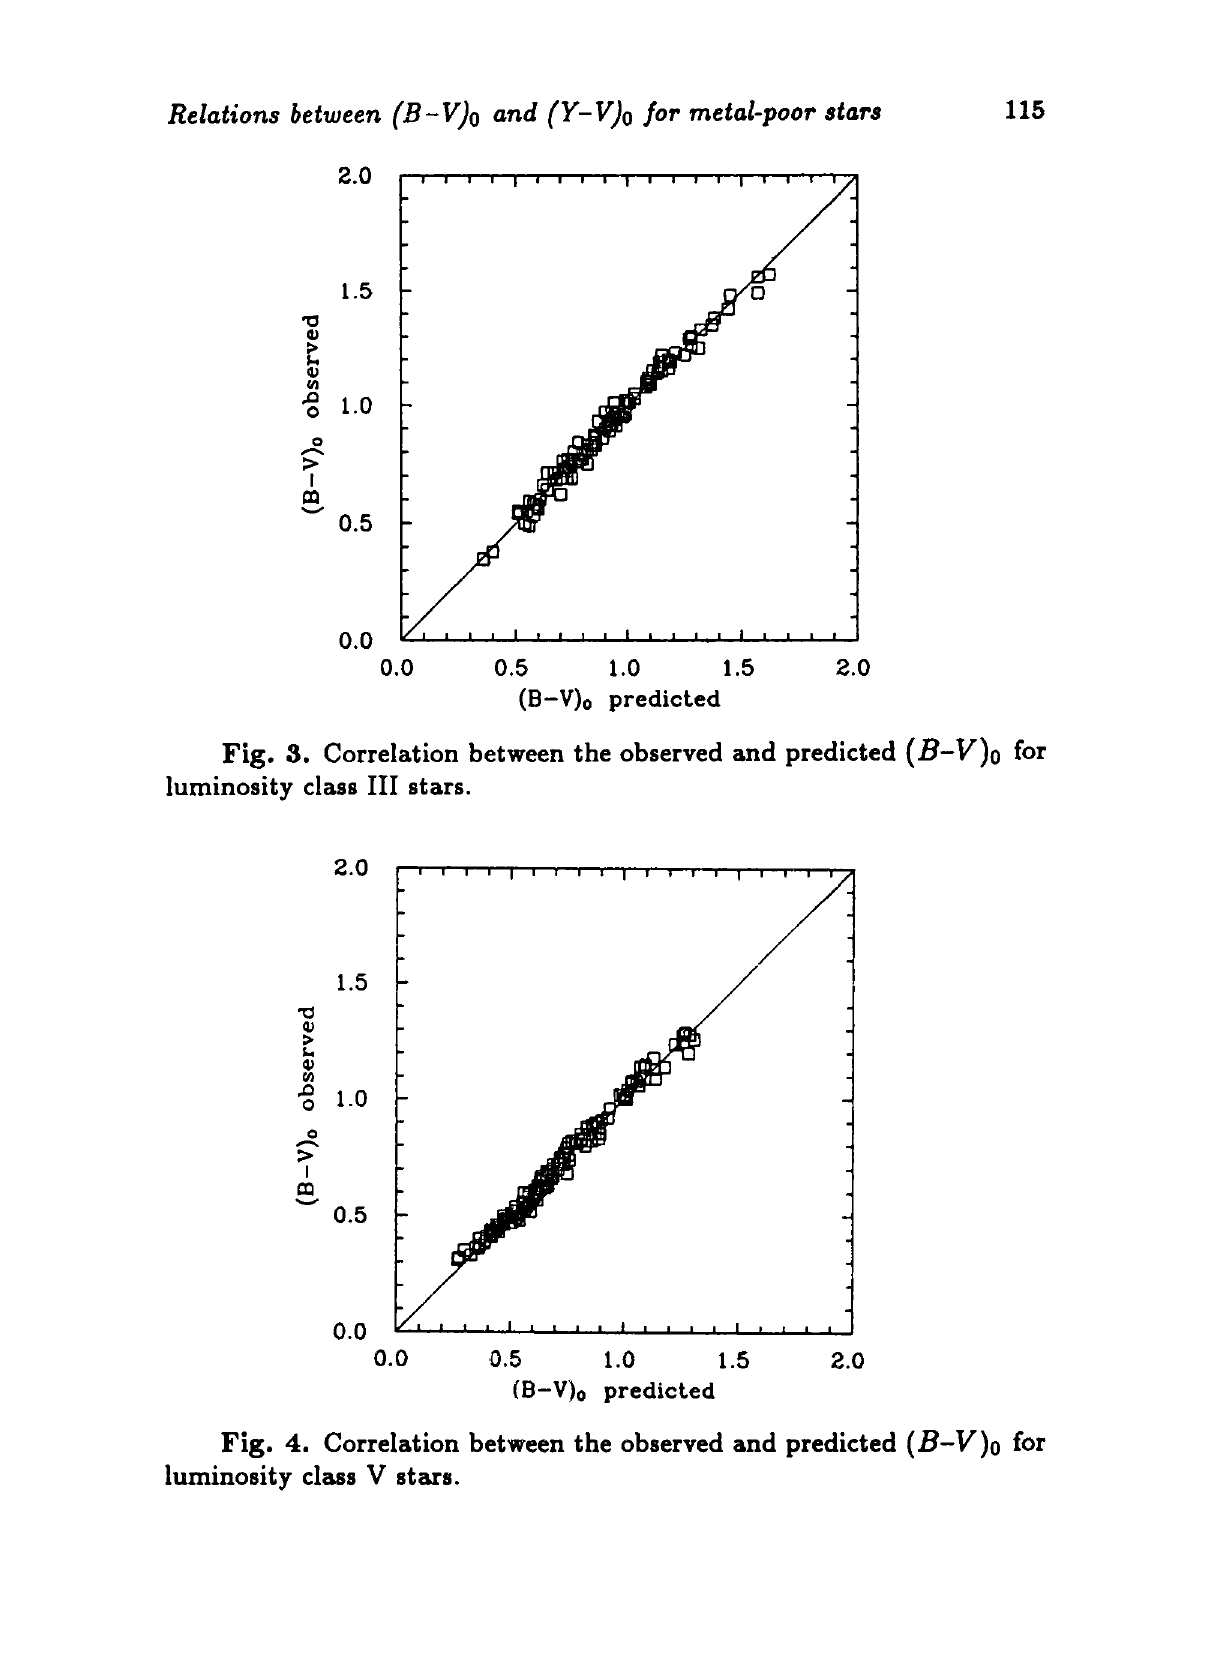
Fig. 4. Correlation between the observed and predicted (B-V)o for luminosity class V